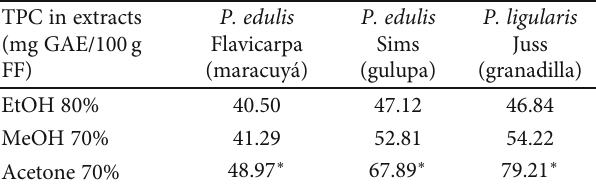
Table 3: TPC in Passi fl oras extracted with three di ff erent solvents ( ∗ best outcome and signi fi cant di ff erences according to ANOVA and post hoc Tukey ’ s HSD test, p < 0 : 05